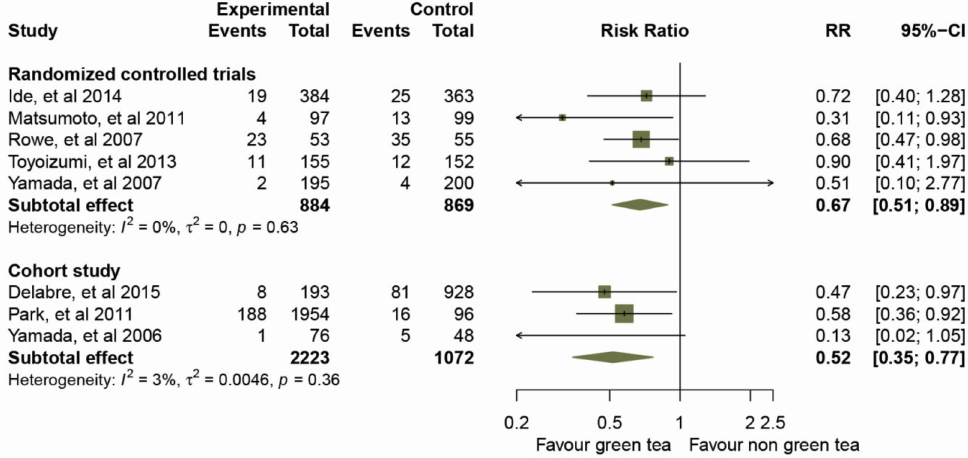
Figure 3. Effect of green tea on preventative influenza virus infection determined by subgroup analysis of RCTs and cohort